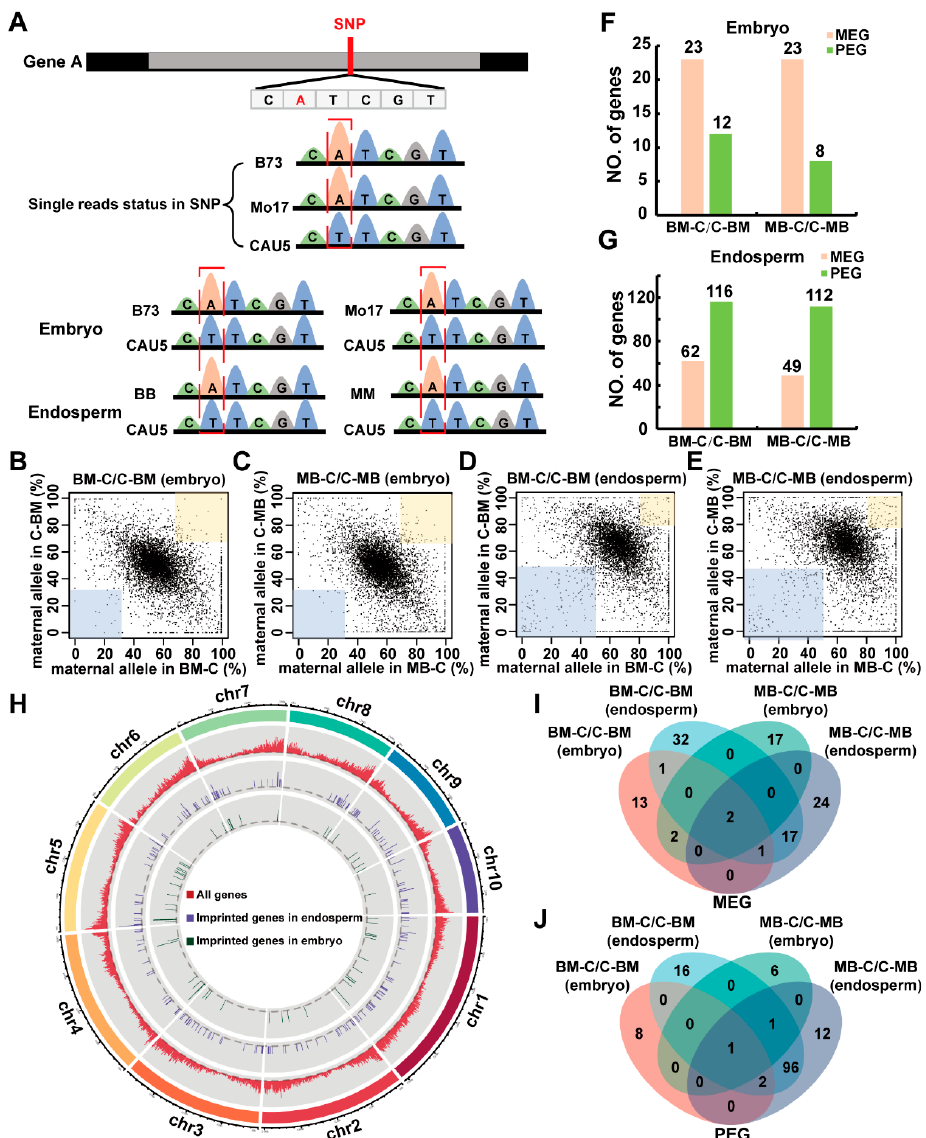
Figure 1. Discovery of imprinted genes detected in the embryo and endosperm of two reciprocal hybrids (BM ‐ C/C ‐ BM and MB ‐ C/C ‐ MB). ( A ) The SNP locus used for distinguishing the parental reads origin. ( B – E ) The proportion of parental transcripts in two reciprocal hybrids (BM ‐ C/C ‐ BM, MB ‐ C/C ‐ MB). ( F , G ) The number of imprinted genes identified in the embryo and endosperm. Pink and green rectangles represent the number of MEG and PEG in the embryo ( F ) and endosperm ( G ). ( H ) Chromosomal distribution of imprinted genes identified in the embryo and endosperm from BM ‐ C/C ‐ BM and MB ‐ C/C ‐ MB crosses. The red, purple and dark ‐ green lines represent, respectively, all genes, imprinted genes identified in the endosperm and imprinted genes identified in the embryo. ( I , J ) Comparison of MEG and PEG numbers identified in the embryo and endosperm from BM ‐ C/C ‐ BM and MB ‐ C/C ‐ MB crosses.